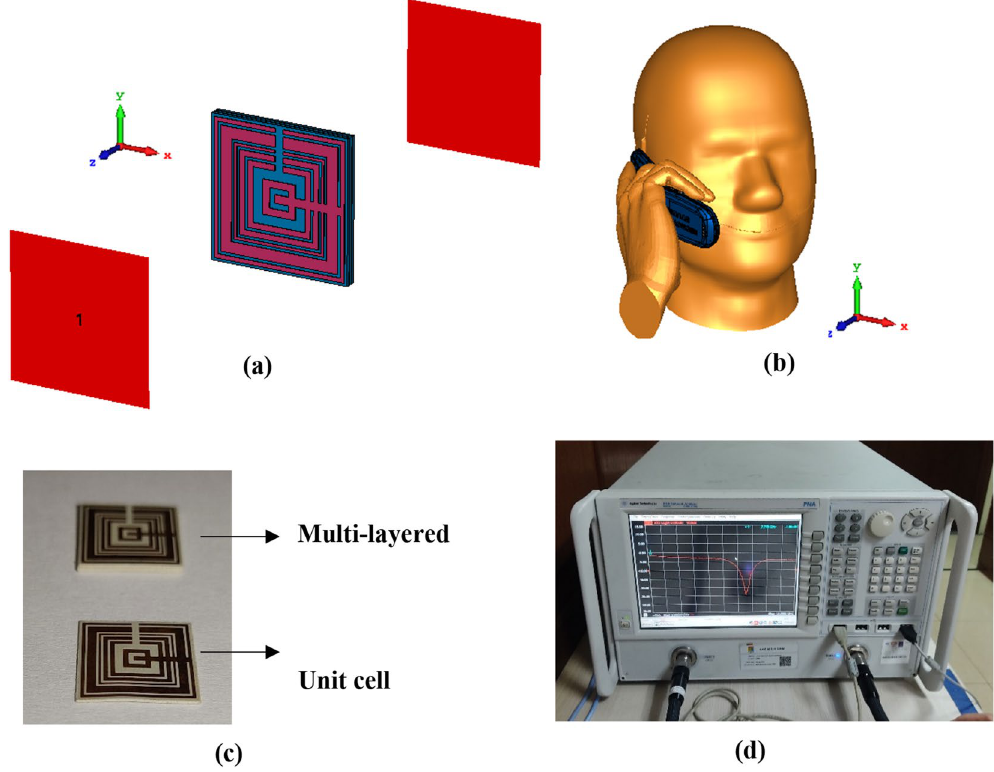
Figure 2. Numerical simulation geometry: (a) MSM structure, (b) Voxel human head and hand model, (c) Fabricated MSM structure, (d) Agilent N5227A VNA